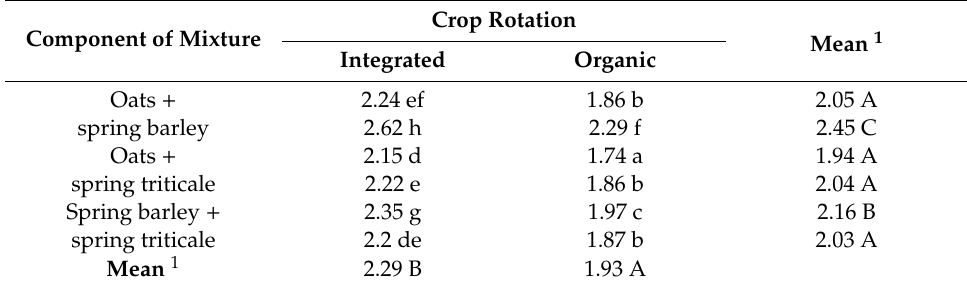
Table 5. Grain yields (t ha − 1 ) of the components of the spring cereal mixtures in the integrated or organic crop rotations, means for the years